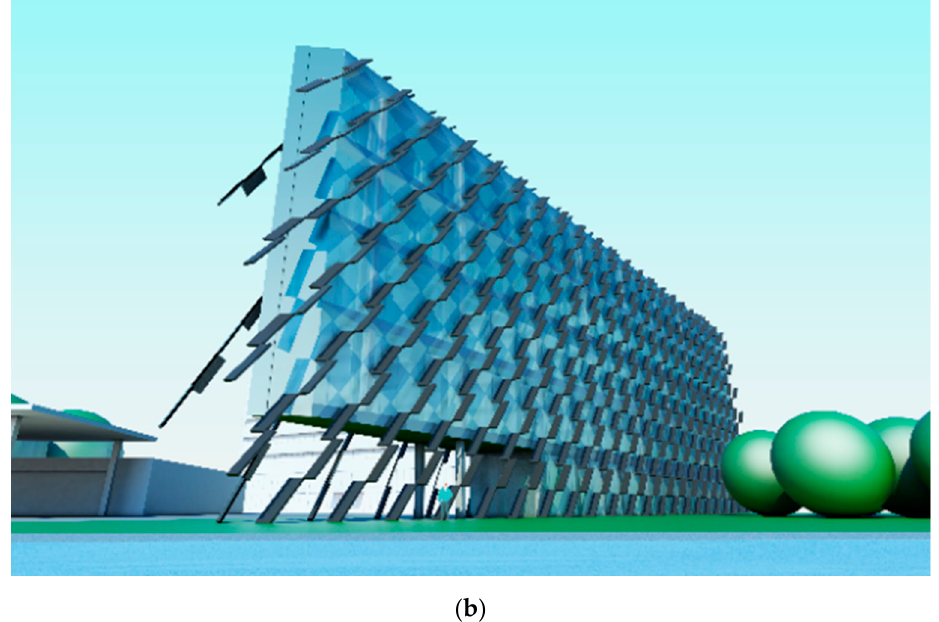
Figure 15. Study of the sun shading of an office building fitted with PV panels located on geographical coordinates 50°5.118 ′ N and 19°56.096 ′ E (author: P. Filipek). ( a ) building ’s location, ( b ) building model and its shading pattern.